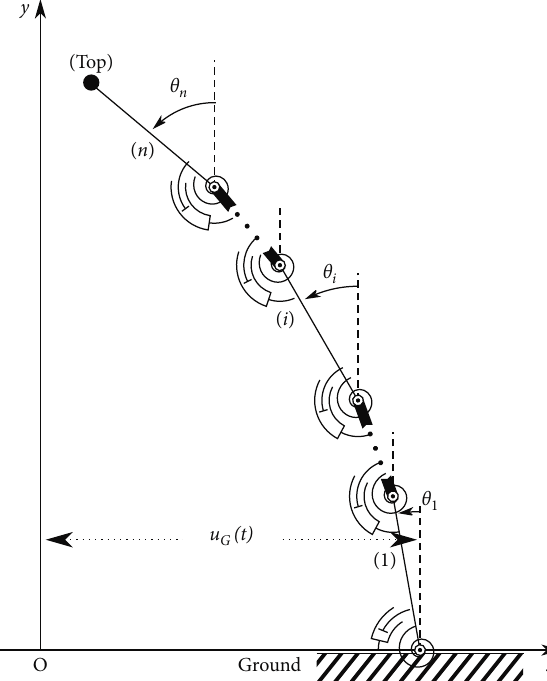
Figure 6: Reference frame and configuration of the multibody system at some instant of time.